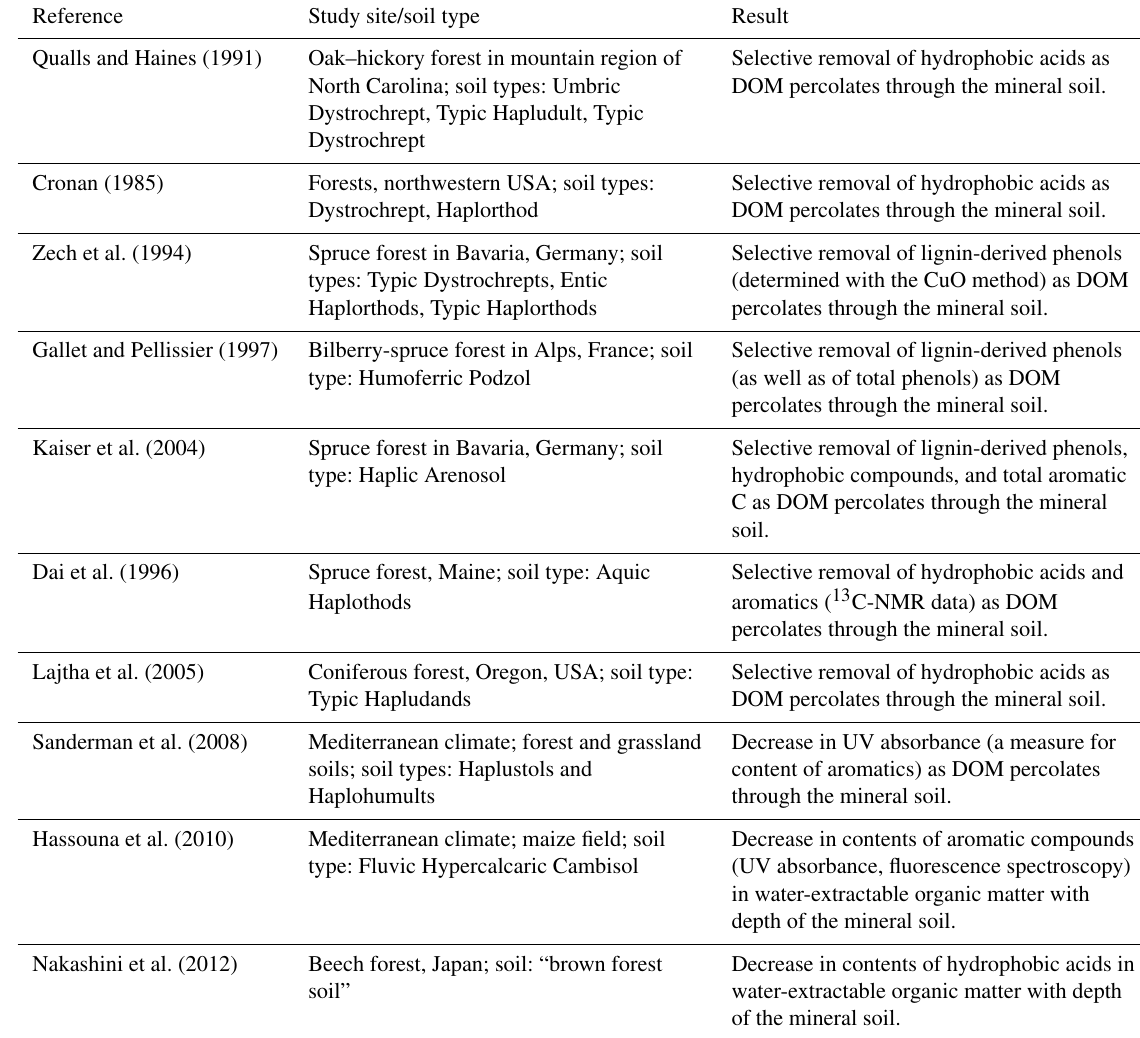
Table 1. Evidence from field studies suggesting that dissolved aromatics (products of lignin depolymerization or tannins) disappear quickly once entering mineral